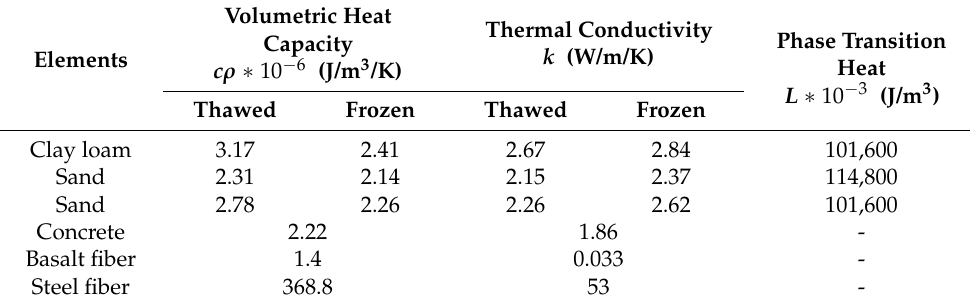
Table 2. Thermal-physical characteristics of soils.